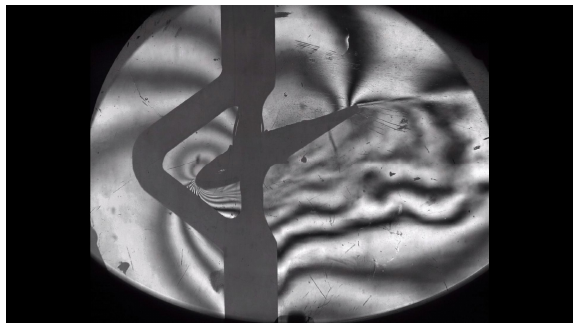
Fig. 13e. Interferogram, separated flow at lower airfoil side.